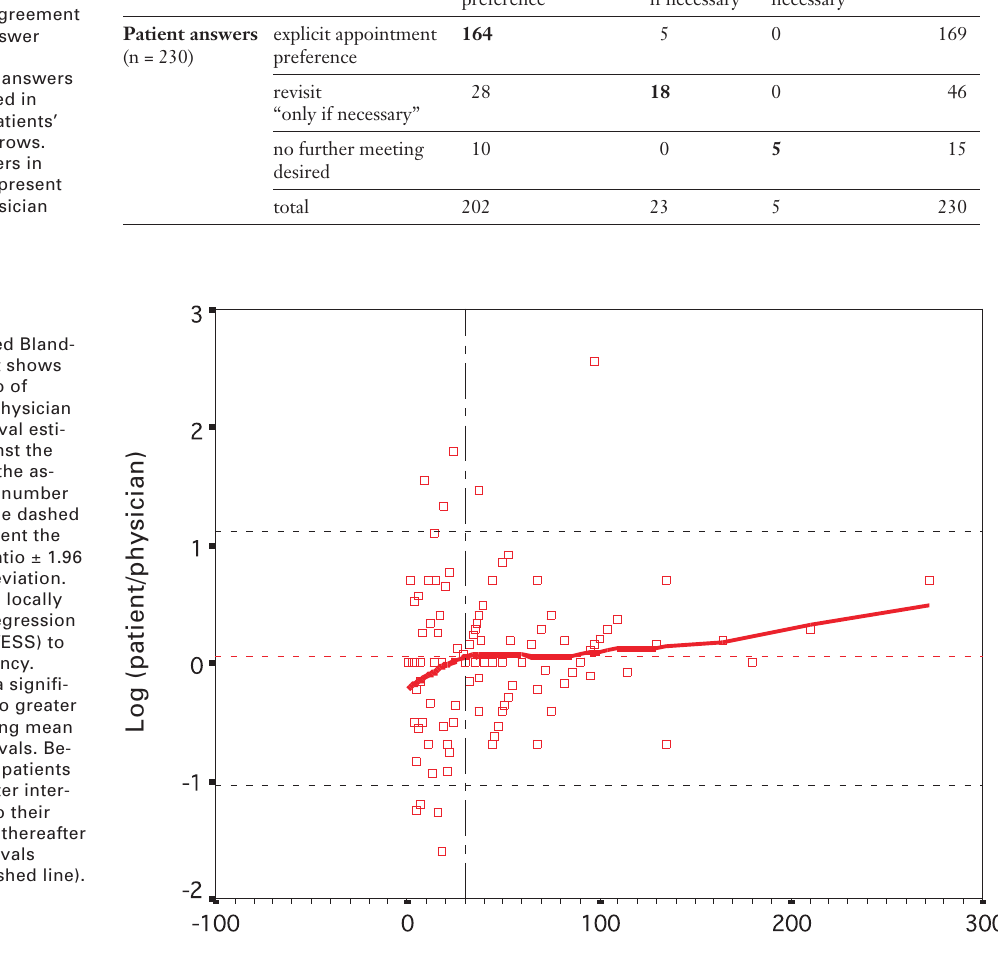
3 x 3 contingency table for patient- physician agreement on three answer categories. Physicians’ answers